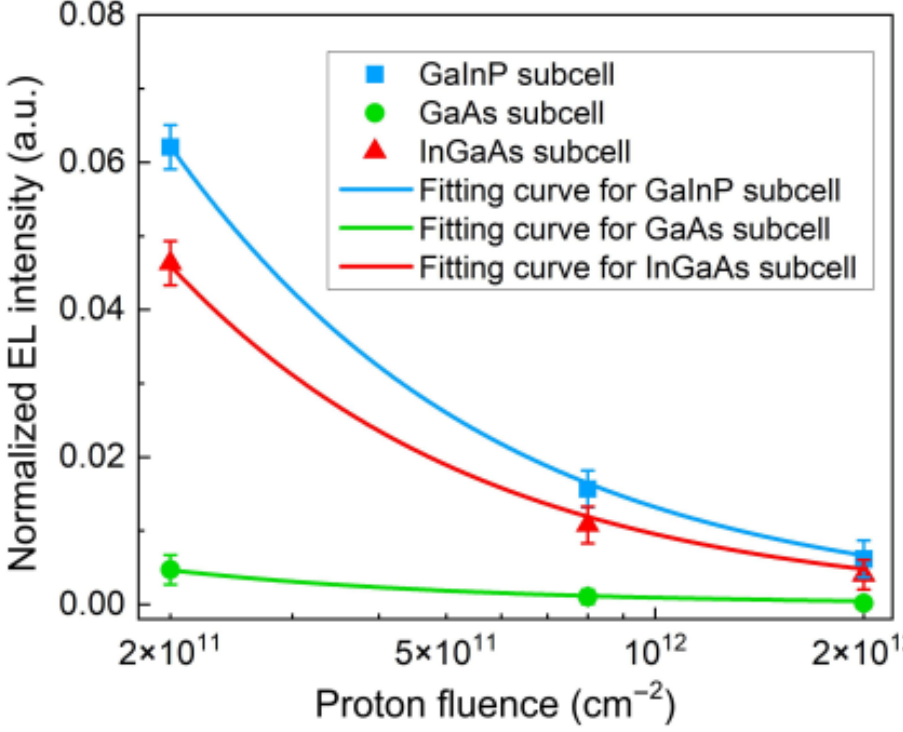
Figure 3. The variation in EL peak intensity of GaInP, GaAs, and InGaAs subcells with proton irradiation